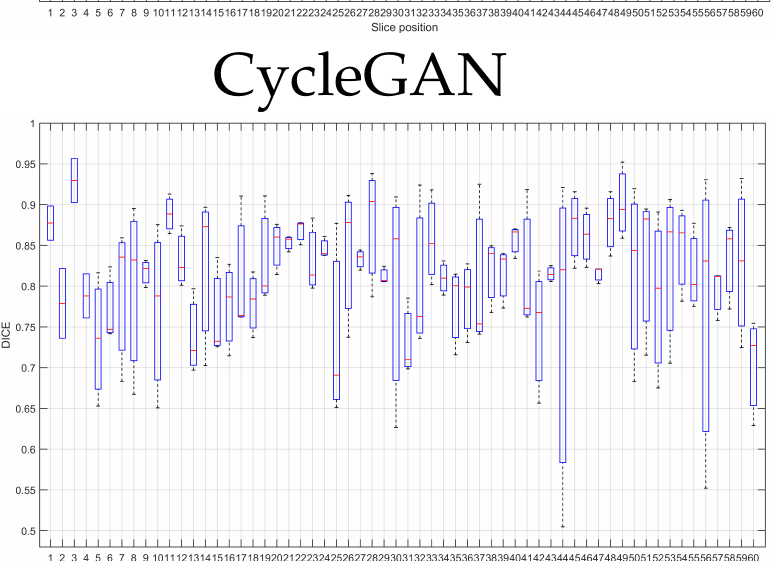
slice position. Figure 10. Segmentation test set DICE results by